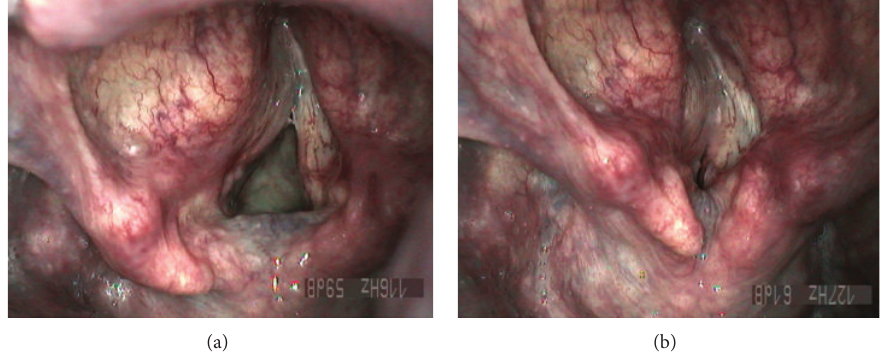
Figure 2: Laryngoscopy (inspiration and phonation) with left paraglottic ARM.